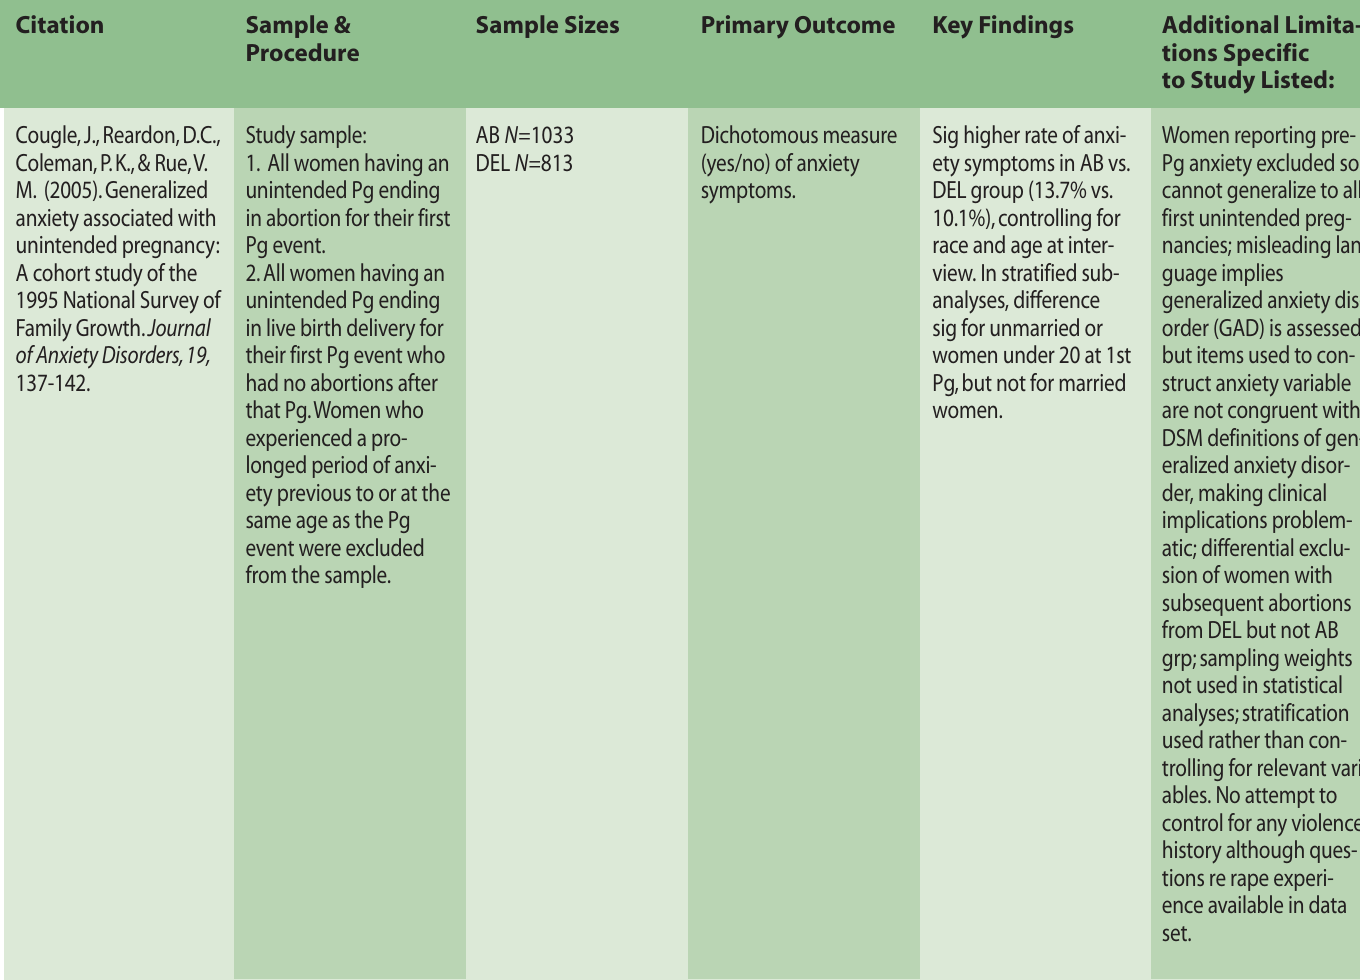
Table 2: Secondary Analyses of Survey Data–Abortion vs.Comparison Groups U.S.STUDIES